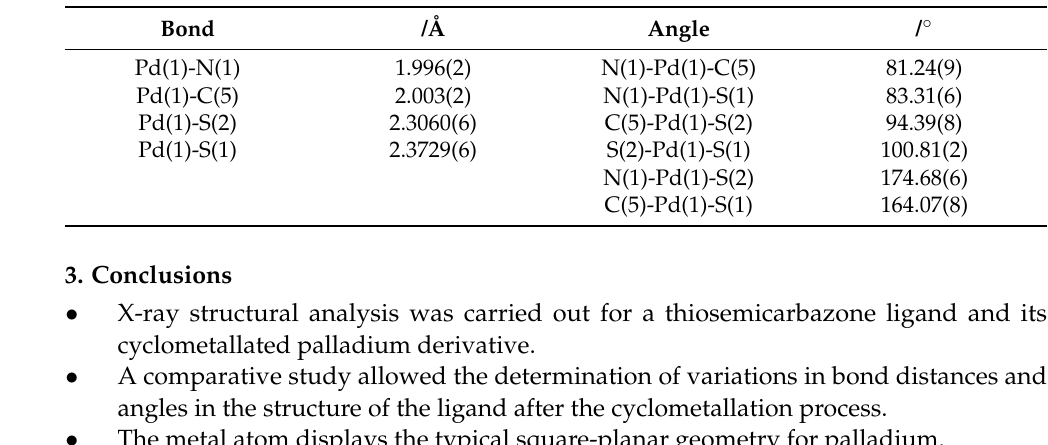
Table 3. Distance bonds (Å) and angles ( ◦ ) around palladium metal